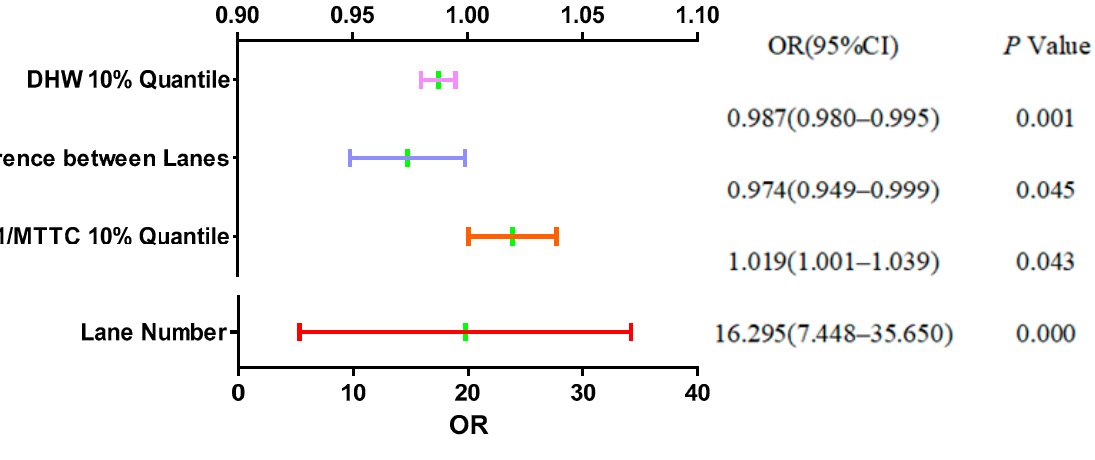
Figure 10. ORs of feature variables.